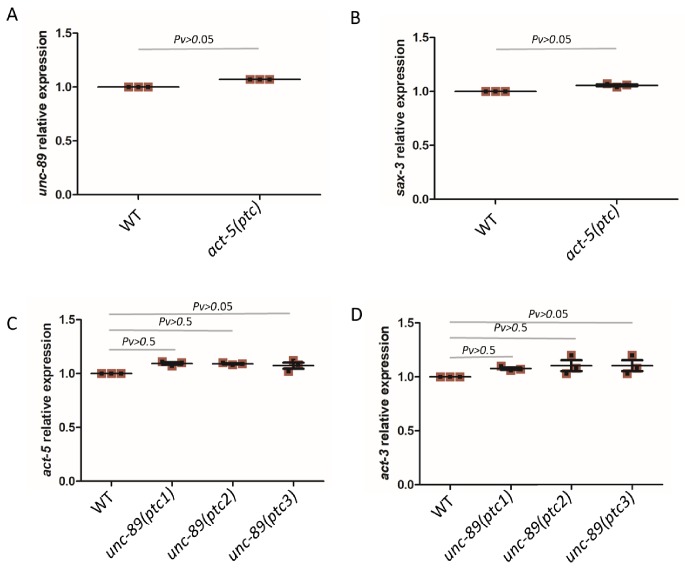
mRNA levels in WT and mutant alleles.qPCR analysis of unc-89 (A) and sax-3 (B) mRNA levels in WT and act-5(ptc) mutants as well as of act-5 (C) and act-3 (D) in WT and unc-89(ptc1), unc-89(ptc2) and unc-89(ptc3) mutants. WT expression levels are set at 1. Data are mean ± S.E.M.; Two-tailed Student’s t-test was used to calculate P values.